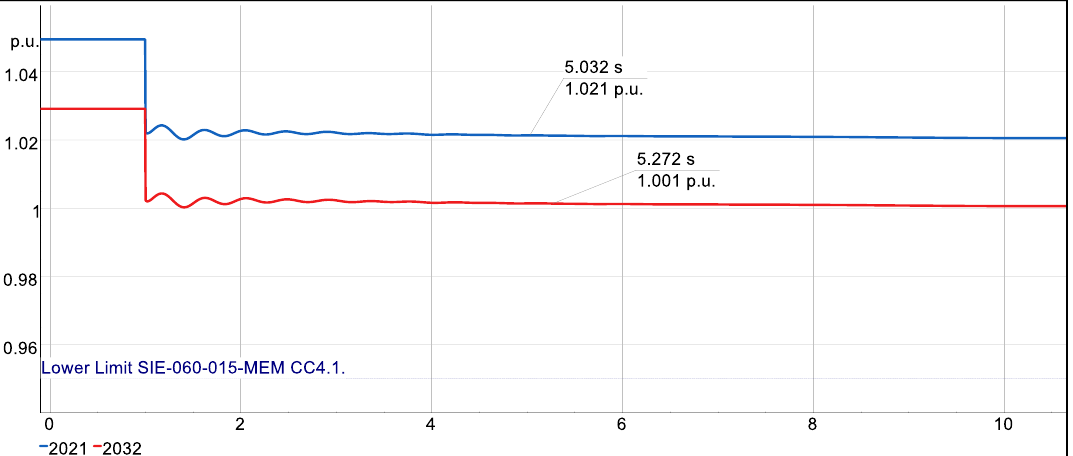
Figure 12. Comparison of voltage in the Pedernales bus bar before the entry of a large load.